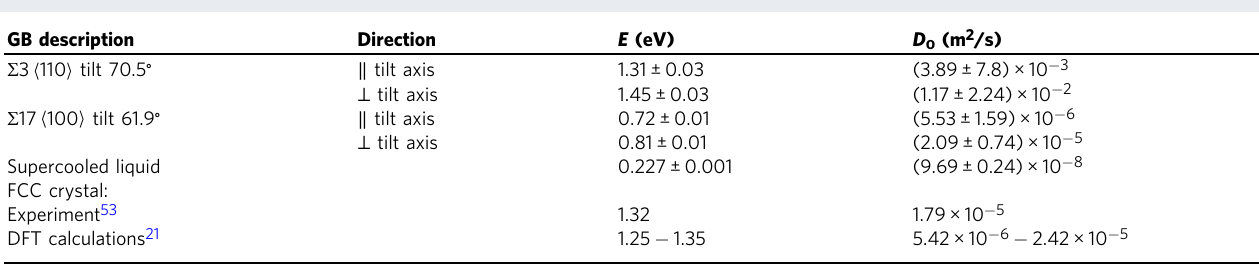
Fig. 1 Atomic structures and diffusion coef fi cients for the Al Σ 3 and Σ 17 GBs. a , b The optimized GB structures as viewed parallel (left column) and normal (right column) to the tilt axis. Atoms identi fi ed with perfect FCC coordination via common neighbor analysis are colored grey and all other atoms are colored red. c Arrhenius diagram of GB diffusion coef fi cients parallel ( D ∣∣ ) and perpendicular ( D ⊥ ) to the tilt axis. The vertical line indicates the melting point predicted by the interatomic potential. Shown for comparison are the computed diffusivities in liquid Al and the experimental (dashed stripe) 53,54 and computed (lower stripe) 21 literature data for self-diffusion in FCC Al. Table 2 Activation energies ( E ) and prefactors ( D 0 ) for self